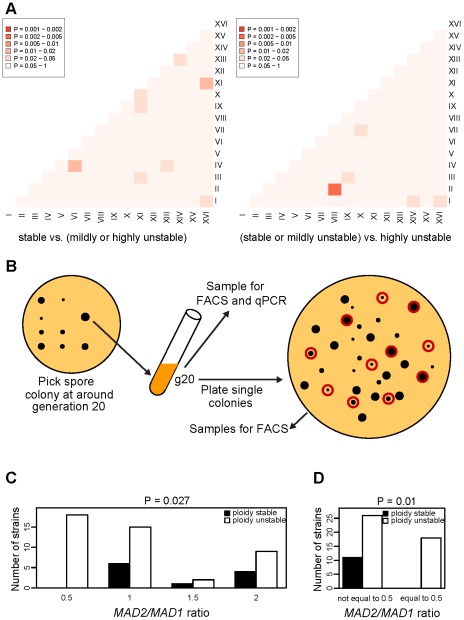
Association of chromosome copy number imbalance with CIN.(A) Enrichment of strains belonging to the combined MU and HU classes of CIN relative to the S class (left) or to the HU class of CIN relative to the combined S and MU classes (right) among aneuploid strains displaying a particular chromosome copy number imbalance, calculated for each non-redundant pair of chromosomes. The enrichment is color-coded based on p-values calculated by means of Hypergeometric tests. Darker colors indicate more significant enrichment of strains belonging to the S class of CIN (left) or HU class of CIN (right) among strains with a non-1 copy number ratio between a given pair of chromosomes. (B) Diagram illustrating the experimental design for the assessment of the relationship between CIN and MAD2:MAD1 ratio in 56 freshly generated aneuploid strains from isogenic triploid sporulation. (C–D) Frequency of aneuploid strains with stable or unstable ploidy grouped by their MAD2:MAD1 ratio. Ploidy-stable strains (black histograms) were identified on the basis of their low level of ploidy variation among single colonies analyzed by FACS; ploidy-unstable strains (white histograms) were identified on the basis of high ploidy variation among single colonies. MAD2:MAD1 ratios were determined by qPCR and are indicated on the x-axis. P-values at the top of (C–D) graphs refer to statistical association between the stability category and the MAD2:MAD1 ratio category by means of a Fisher's exact test. Aneuploid strains were divided into all four possible MAD2:MAD1 ratio classes (C) or based on MAD2:MAD1 ratio equal or not equal to 0.5 (D).